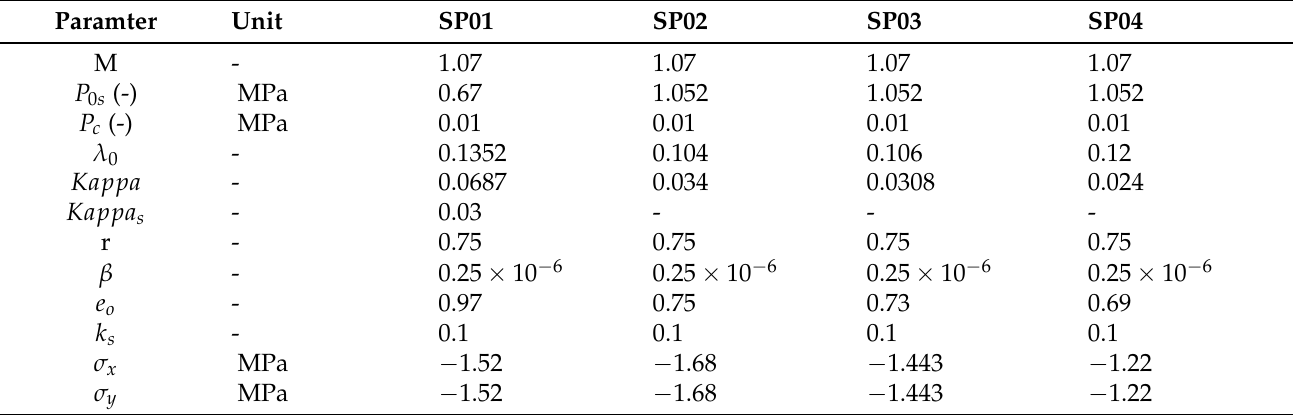
Table 3. Numerical parameters in suction controlled compression.